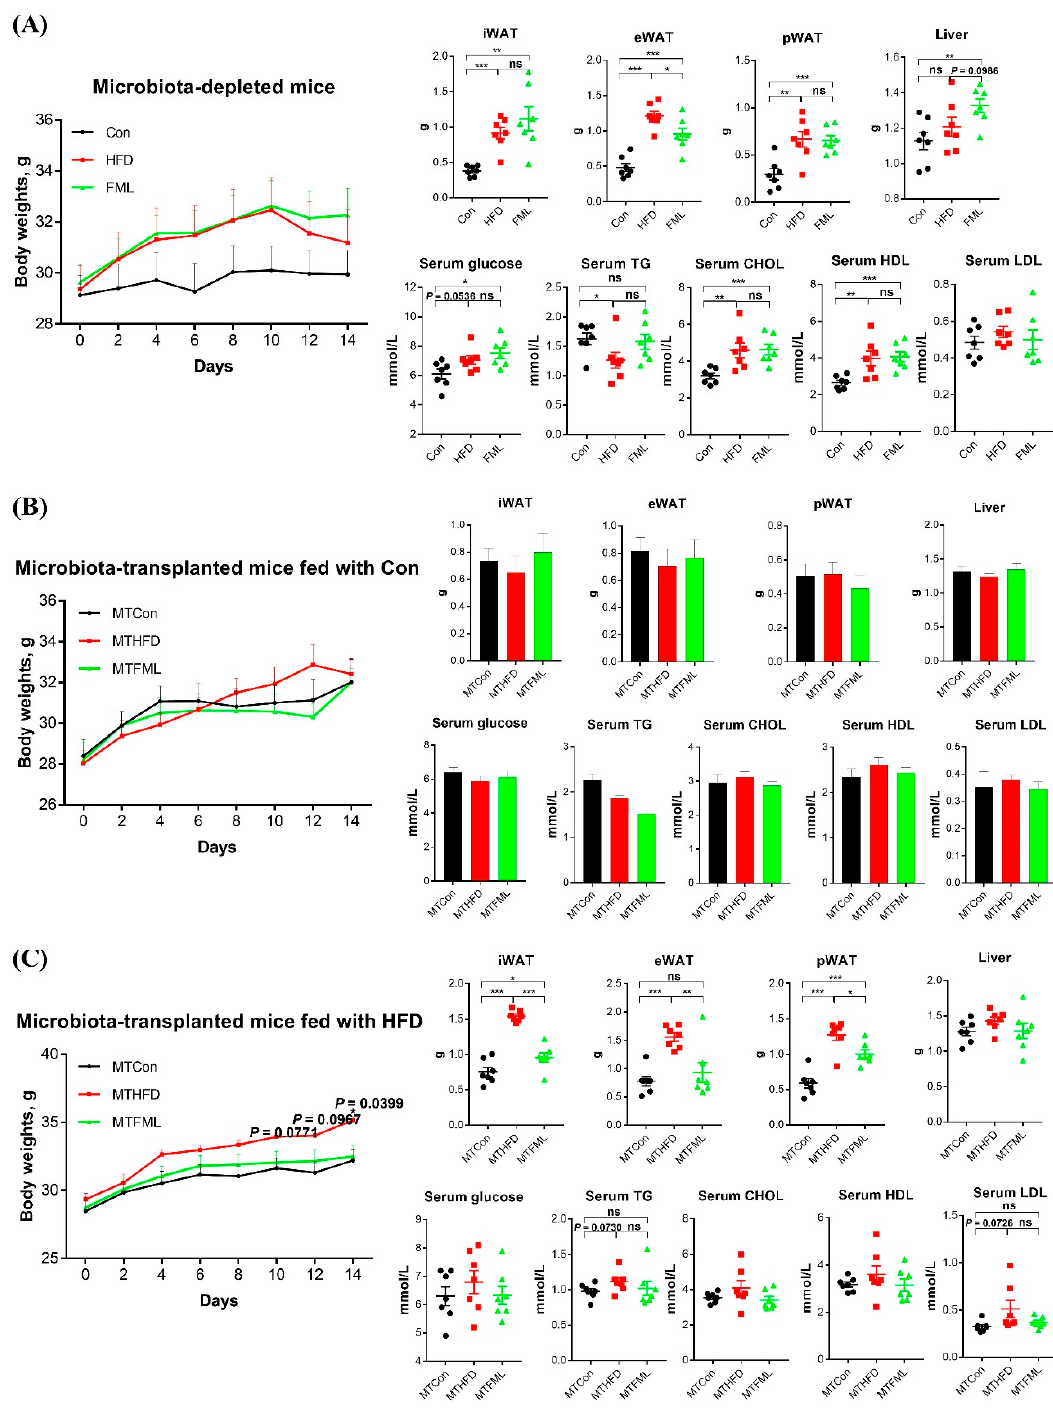
Figure 6. Microbiota deficiency failed to prevent the anti-obese effect of FML in HFD-fed mice, but microbiota transplantation from FML-treated mice improved lipid metabolism in HFD-fed mice but not in Con-fed mice ( n = 7). Body weight, liver weight, iWAT weight, eWAT weight, pWAT weight, and serum levels of glucose, TG, CHOL, HDL, and LDL in microbiota-depleted mice ( A ), microbiota-transplanted mice fed with Con ( B ), and microbiota-transplanted mice fed with HFD ( C ). Data are presented as mean ± SEM, differences were denoted as follows: * p < 0.05, ** p < 0.01, *** p < 0.001; ns p > 0.05.